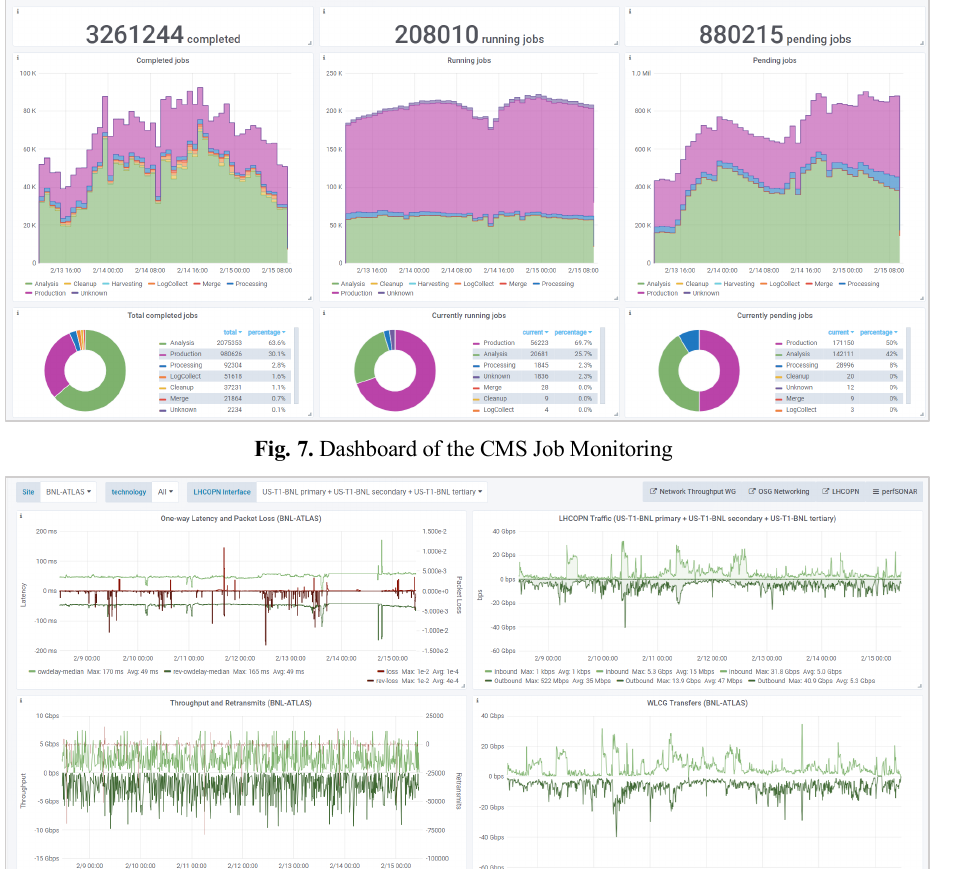
Fig. 5. Dashboard of the WLCG Transfers of each Experiment